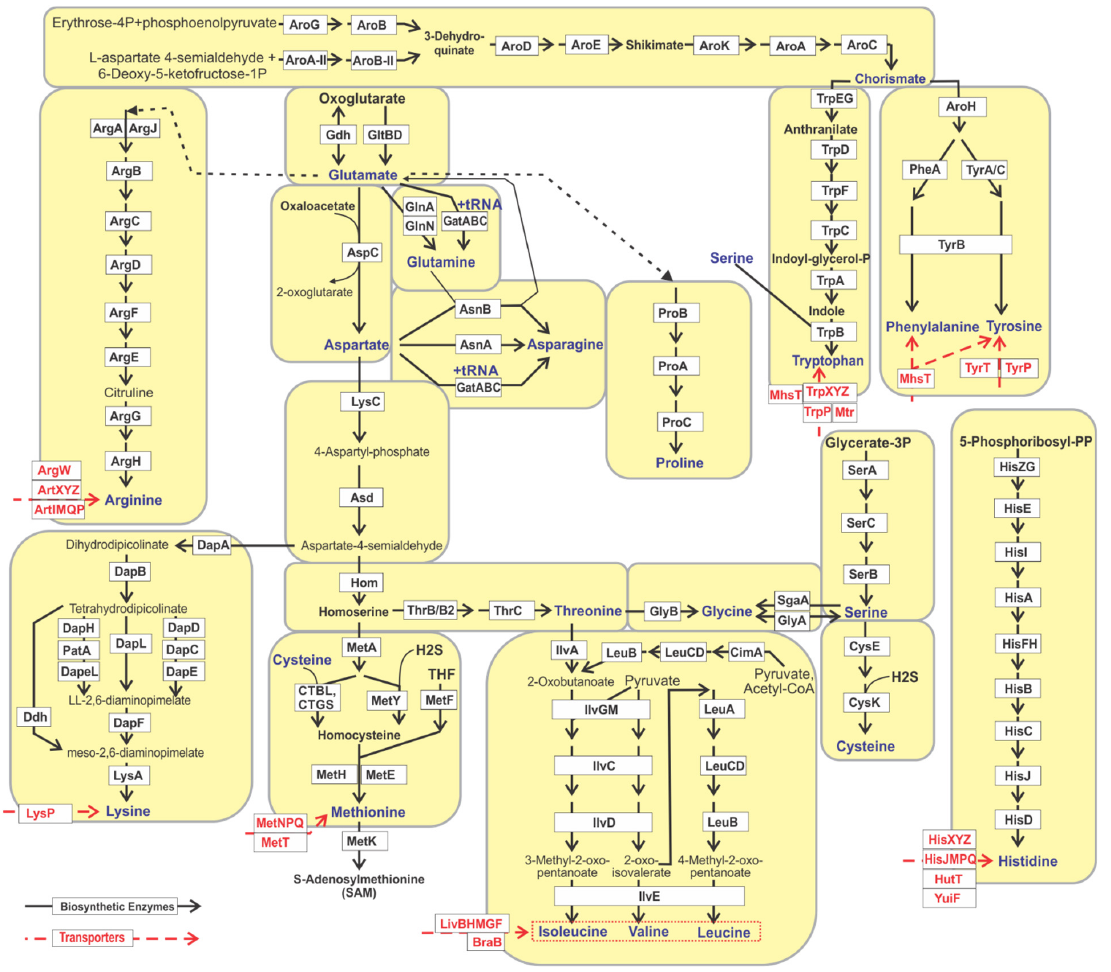
Figure 1. Reconstructed amino acid biosynthesis pathways in HGM genomes. Biosynthetic enzymes are shown in black using solid black arrows. Amino acid uptake transporters are shown in red using dashed red arrows.